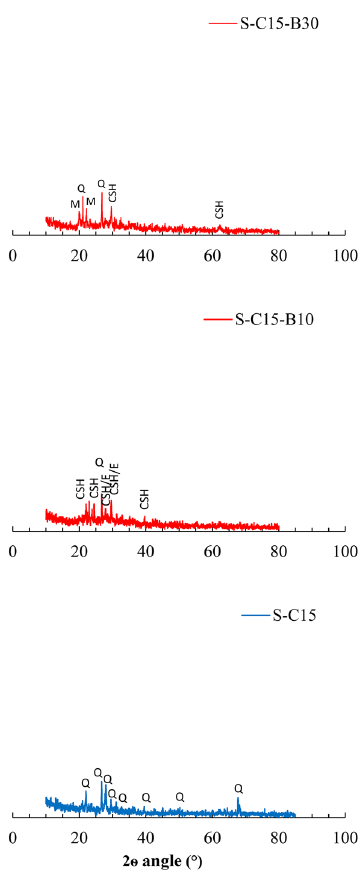
Fig. 25 The XRD graph of mixtures with 15% cement enriched with bentonite additive (Q: quartz, CSH: calcium silicate hydration, M: